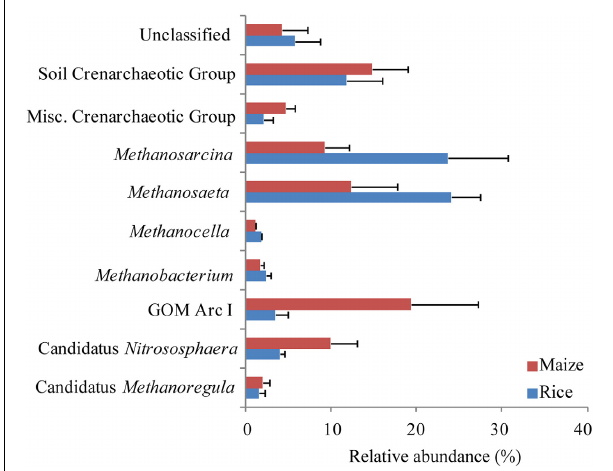
FIGURE 7 | Relative abundance of the archaeal OTUs in rice field soil. Based on relative abundance top 30 OTUs derived from pyrosequencing of the archaeal 16S rRNA were grouped according to their phylogenetic assignment. OTUs were monitored in rice (blue) and maize (red) fields. Columns represent mean and bars standard errors of n =